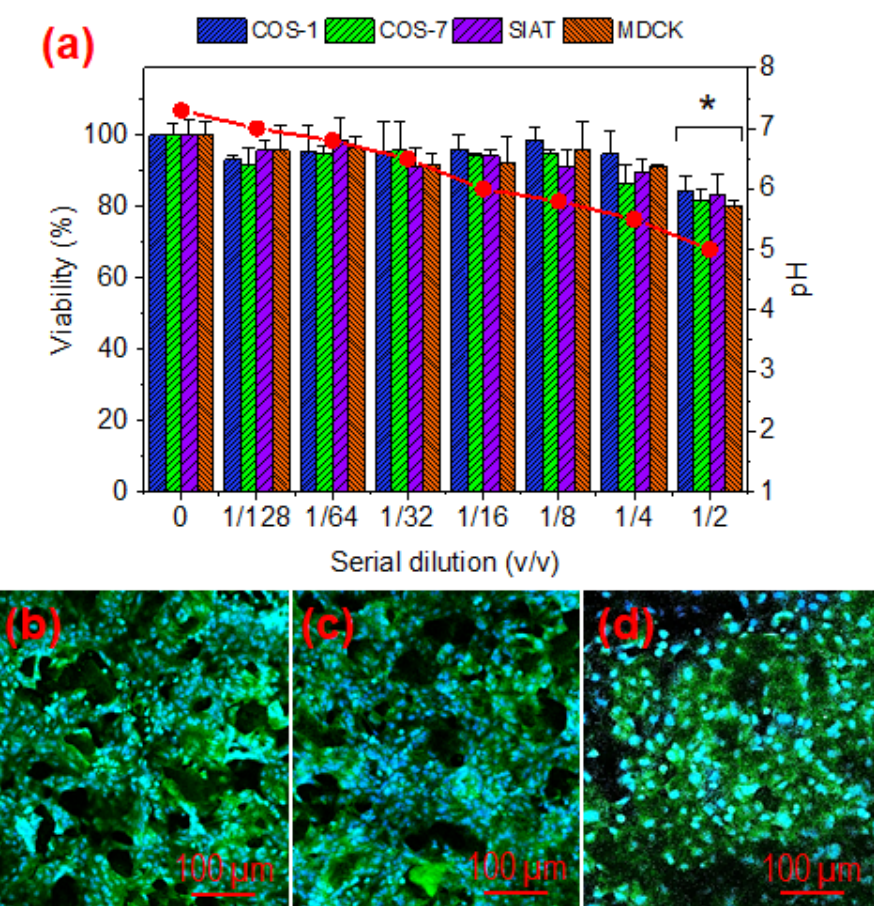
Figure 13. Cytotoxic effect of the γ -PGA hydrogels extract on different cell lines (COS-1, COS-7, SIAT and MDCK). pH (red circles) corresponds to dilution and was not adjusted. The bars are mean ± SD ( n = 3). * p < 0.05, scaffold vs. control, ANOVA followed by Tukey test ( a ). Fluorescence images of MDCK cells cultured for 96 h on hydrogels with 50% ( b ), 75% ( c ), and 100% ( d ) crosslinking degrees. The discontinuity of the monolayer is due to the pores of the hydrogel.